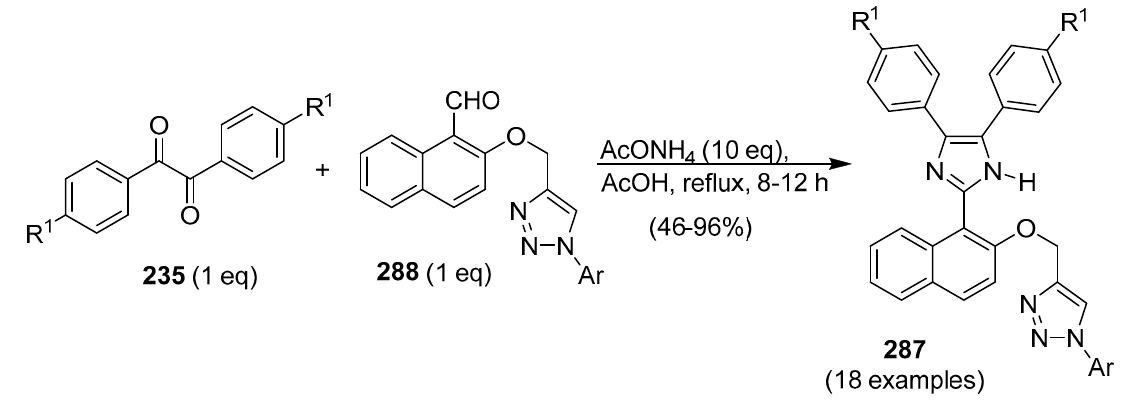
Scheme 56. Synthesis of 2,4,5-trisubstituted 1 H -imidazole/1,2,3-triazole hybrids